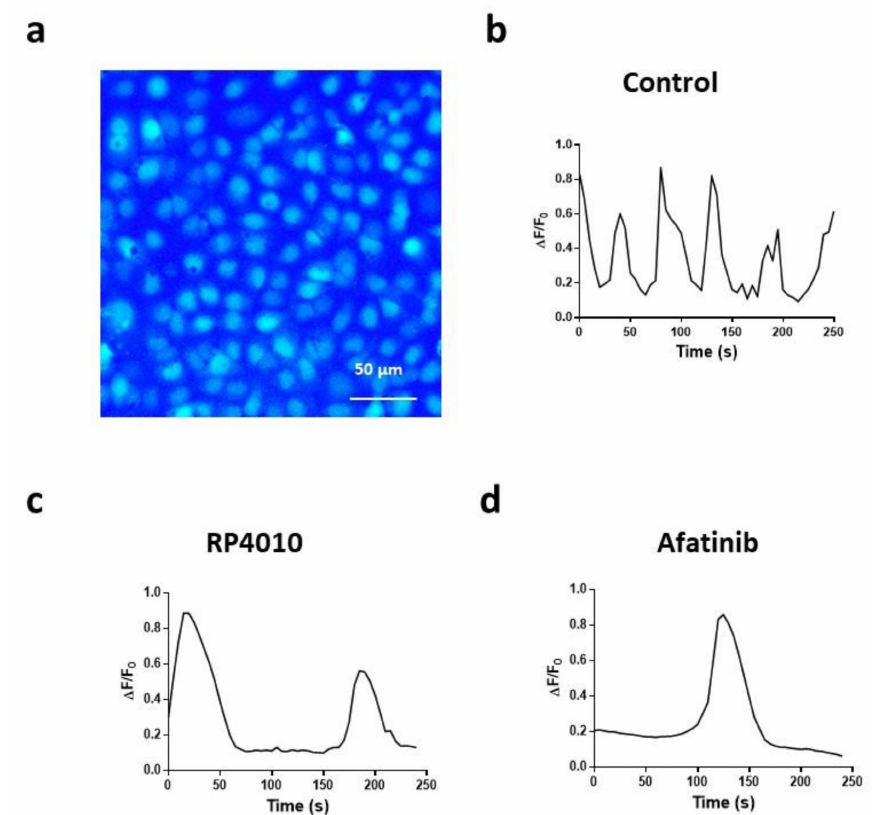
Figure 2. ( a ) Decreased intracellular Ca 2+ oscillations in KYSE-150 cells treated with RP4010 or afatinib. ( b – d ) Fluorescent image of KYSE-150 cells loaded with Fluo-4 AM. Scale bar, 50 µ m. ( b ) Representative traces of Ca 2+ oscillations in a single KYSE-150 cell treated with vehicle control, ( c ) RP4010 or ( d )